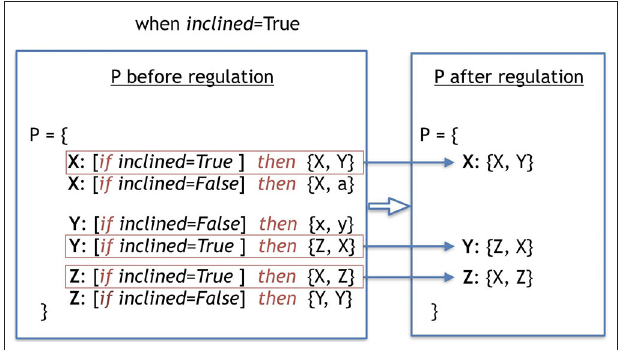
FIGURE 4 | This example shows the process of regulation of a genotype, selecting its rules to be activated due to the environmental variable. The term used to define the environmental variable is called included and was sensed to be True when the regulation process took place. The production-rules in the second frame are the ones that became true given the environmental variable, and thus were selected to be in the final set P , which will be utilized in the early